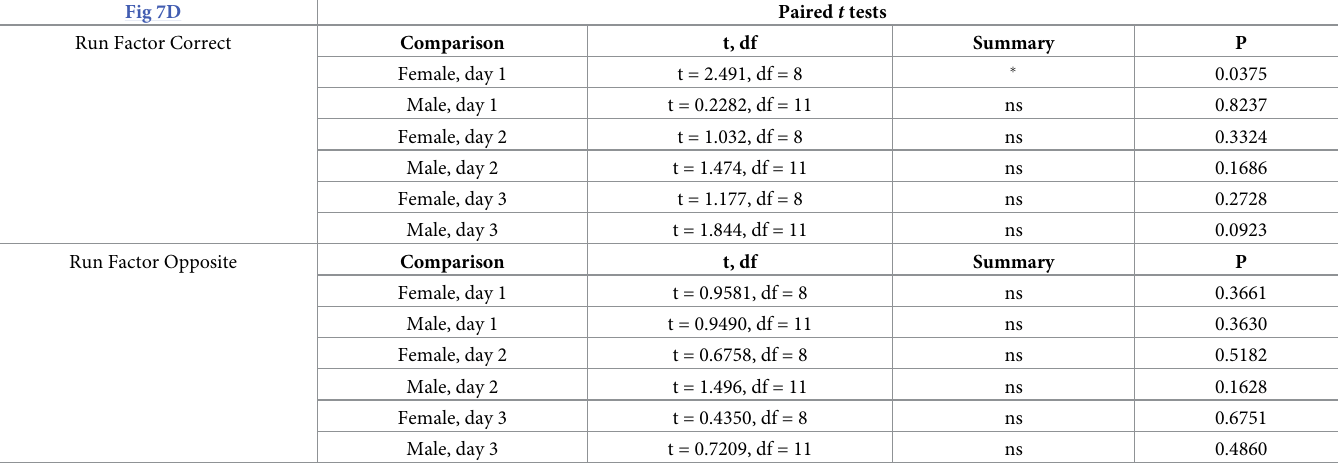
Table 11. Statistical analysis of data shown in Fig 7D for behavioral sequencing, cohort A, Run comparison. Fig